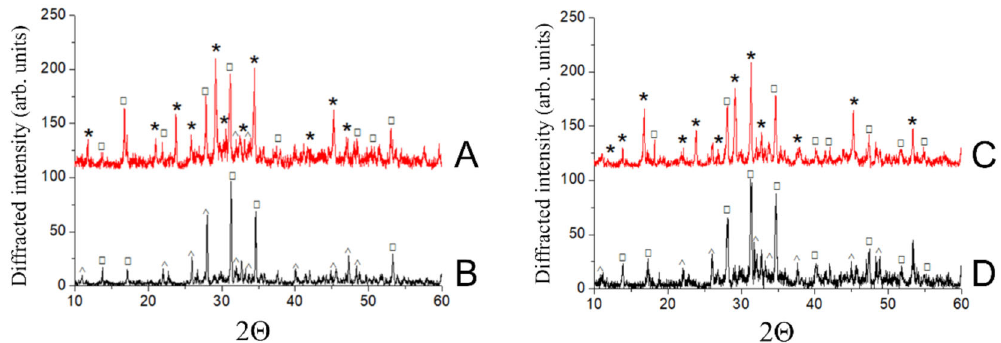
Fig. 1 Diffractograms of: TCP-based cement ( A ) before and ( B ) after soaking in physiological solution and Zn-substituted TCP cement ( C ) before and ( D ) after soaking in physiological solution. Labeled peaks